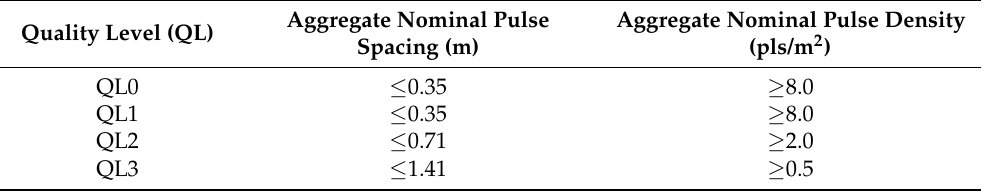
Table 2. Aggregate nominal pulse spacing and density defined in the 3DEP Lidar Base